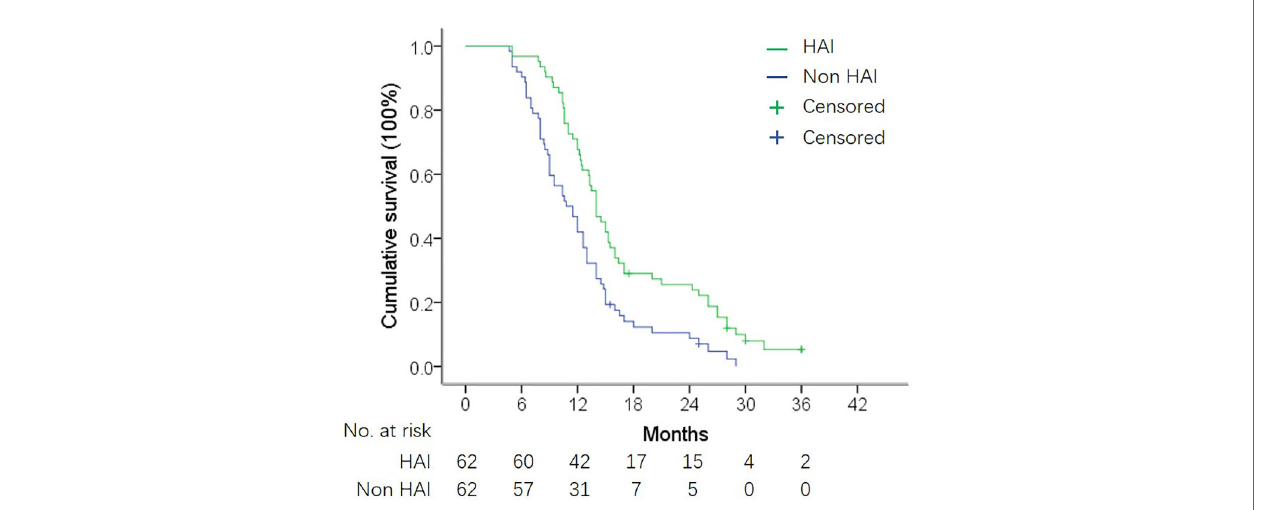
FIGURE 2 | OS in matched HAI and non-HAI group. Median OS was 14.0 months vs. 10.8 months in patients with and without HAI (log-rank test, P = 0.001).